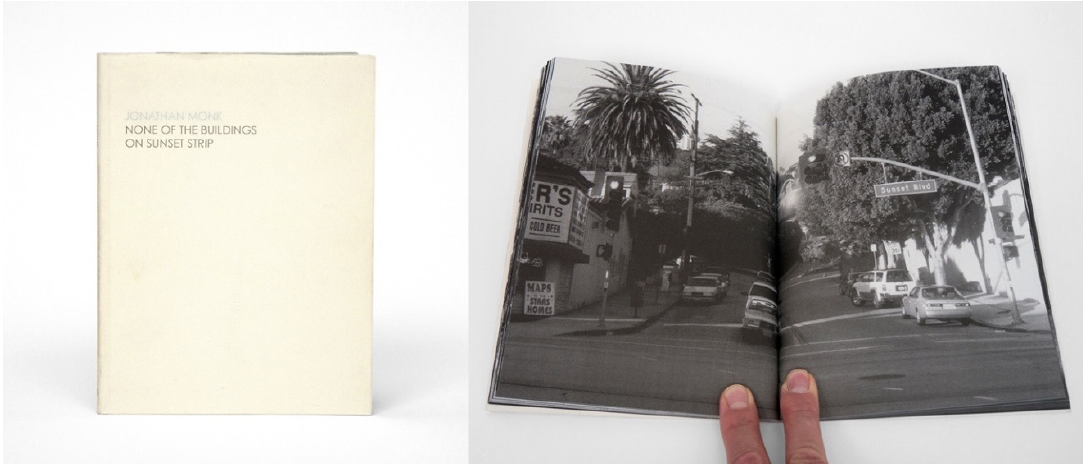
Figure 33. Jonathan Monk, None of the Buildings on the Sunset Strip , 2002.